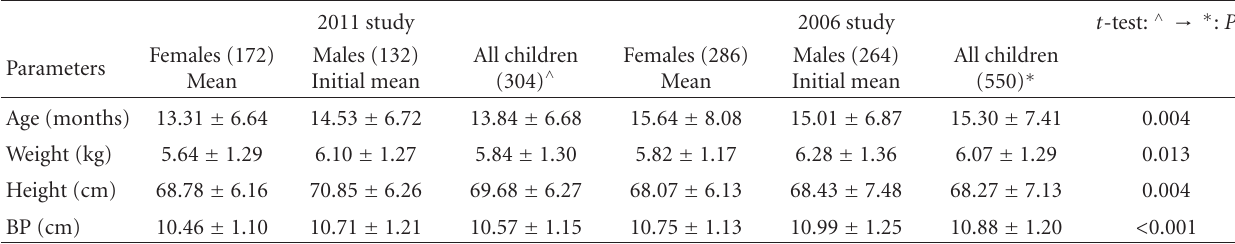
Table 5: Anthropometric parameters according to the two studies.